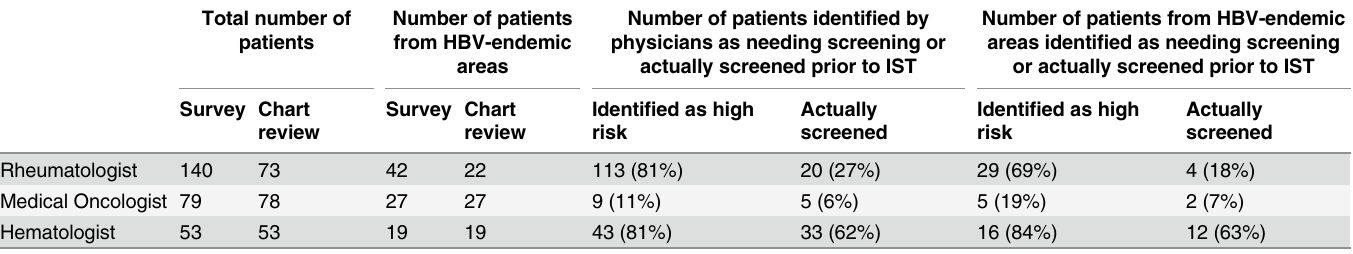
Table 3. Summary of Screening Patterns.